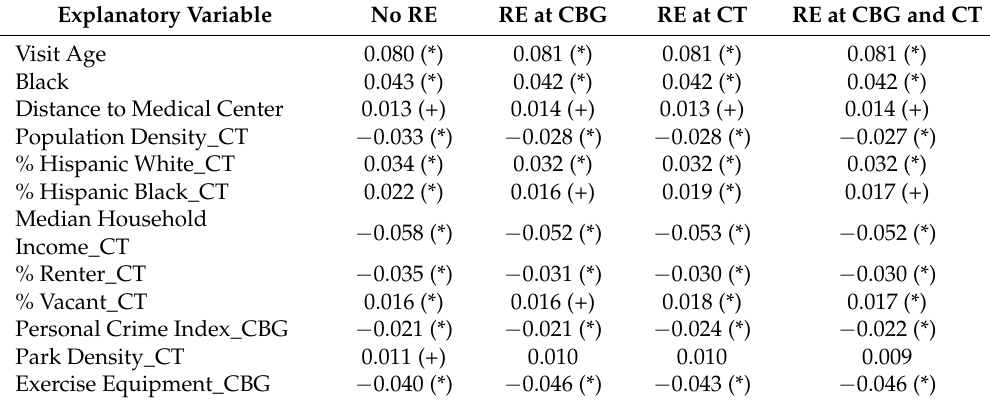
Table 8. Standardized coefficient estimates from the spatial scale (SS) forward stepwise model of BMI z-scores with no random effect (RE) in comparison to standardized coefficient estimates from three mixed models with a RE at the census block group (CBG), the census tract (CT), and the CBG and CT. The mixed models were fit using the covariates that were chosen by the SS stepwise algorithm. The horizontal dashed line separates the individual-level variables and the neighborhood-level variables considered at multiple spatial scales.